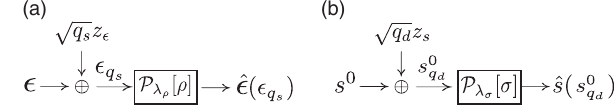
FIG. 3. A low-dimensional scalar MFT for high-dimensional inference. Diagrams (a) and (b) are schematic descriptions of Eqs. (15) and (16). They describe a pair of scalar statistical estimation problems, one for a noise variable ϵ , drawn from P ϵ in (a), and the other for a signal variable s 0 , drawn from P s in (b). Each variable is corrupted by additive Gaussian noise, and from these noise-corrupted measurements, the original variables are estimated through proximal descent steps, yielding a noise estimate ˆ ϵ in (a) and a signal estimate ˆ s in (b). The MFT ϵ ; ˆ ϵ Þ and P s 0 ; ˆ s Þ are obtained by integrating distributions P MF ð MF ð out z ϵ and z s in (a) and (b), respectively. These joint MF distributions describe the joint distribution of pairs of single components ð ϵ μ ; ˆ ϵ μ Þ and ð s 0 i ; ˆ s i Þ in Eq. (1), after integrating out all other elements of the quenched disorder in the training data and true